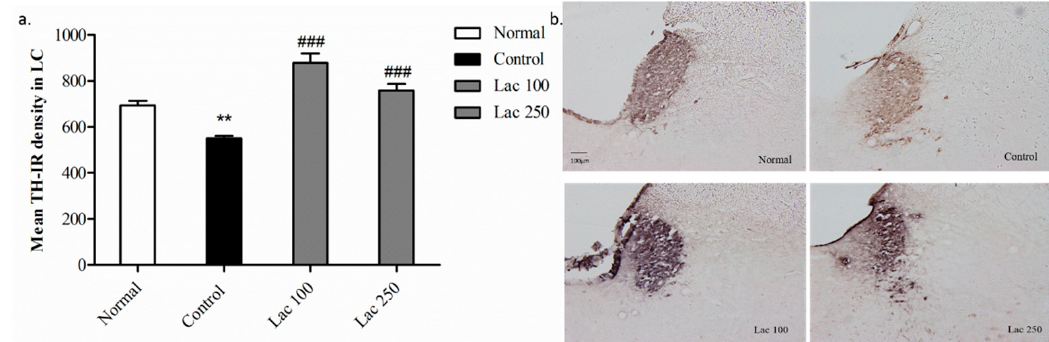
Figure 6. Tyrosine hydroxylase positive (TH+) cell expression in the locus coeruleus (LC) after oral lactate administration. ( a ) Oral lactate administration increased the mean TH- immunoreactive (TH-IR) cell density in ovariectomized rat with repeated stress in comparison to the control group. Values are presented as mean ± SEM. ** show differences between the normal and control groups. ### show significant differences between the control group and treatment group. ### p < 0.001. The p -value of the test was <0.001 by one-way ANOVA, followed by a post hoc LSD test ( n = 6). ( b ) Representative images of TH+ cell expression in all groups in the LC region (magnification 100 × ). TH+ cell density was considerably increased in both lactate treated groups; however, it was denser in the lactate 100 group compared to the lactate 250